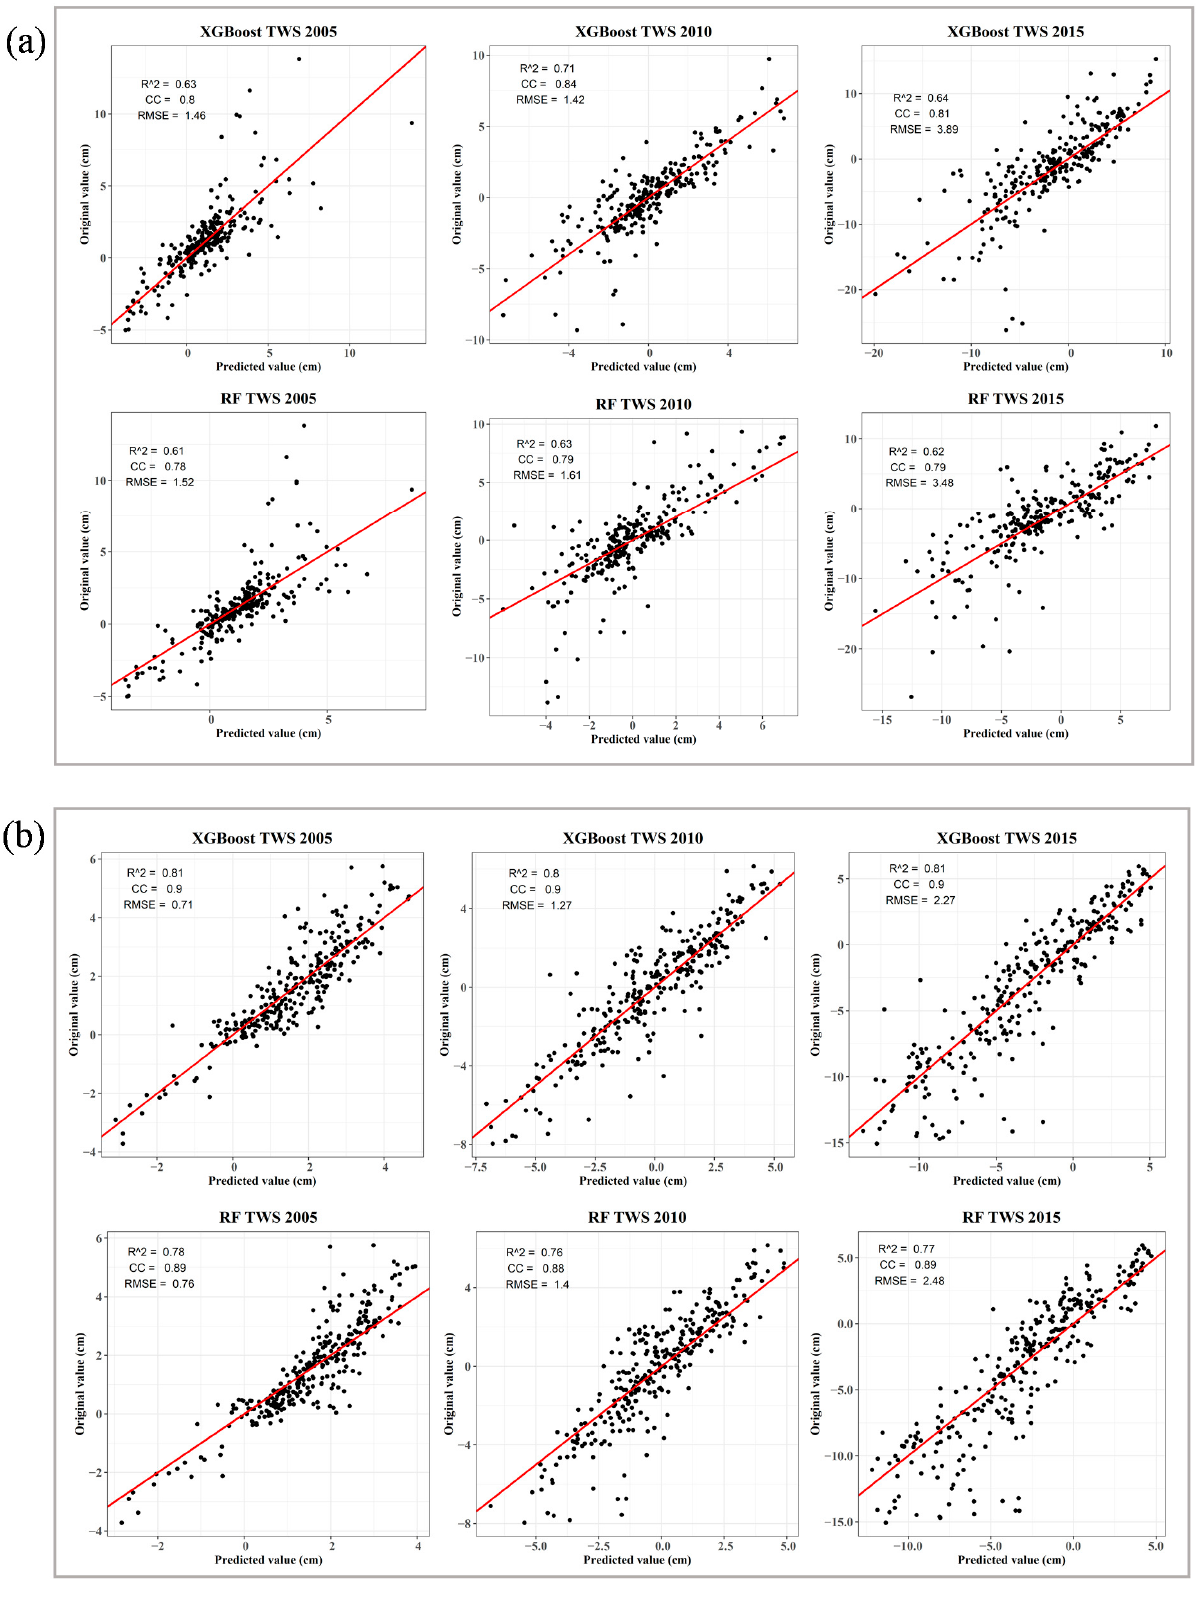
Figure 3. Scatterplots and regression fits of the testing dataset of TWS using XGBoost and RF and the original dataset for 2004 − 2016 based on ( a ) CSR-MS 906 clusters and ( b ) CSR-SH data.